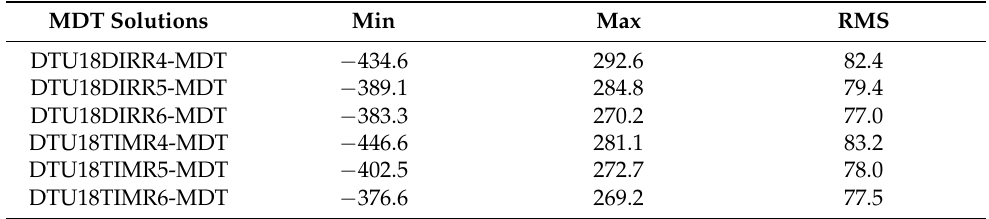
Table 5. Statistics of the differences between the reference MDTs and the estimated MDT (units: mm).